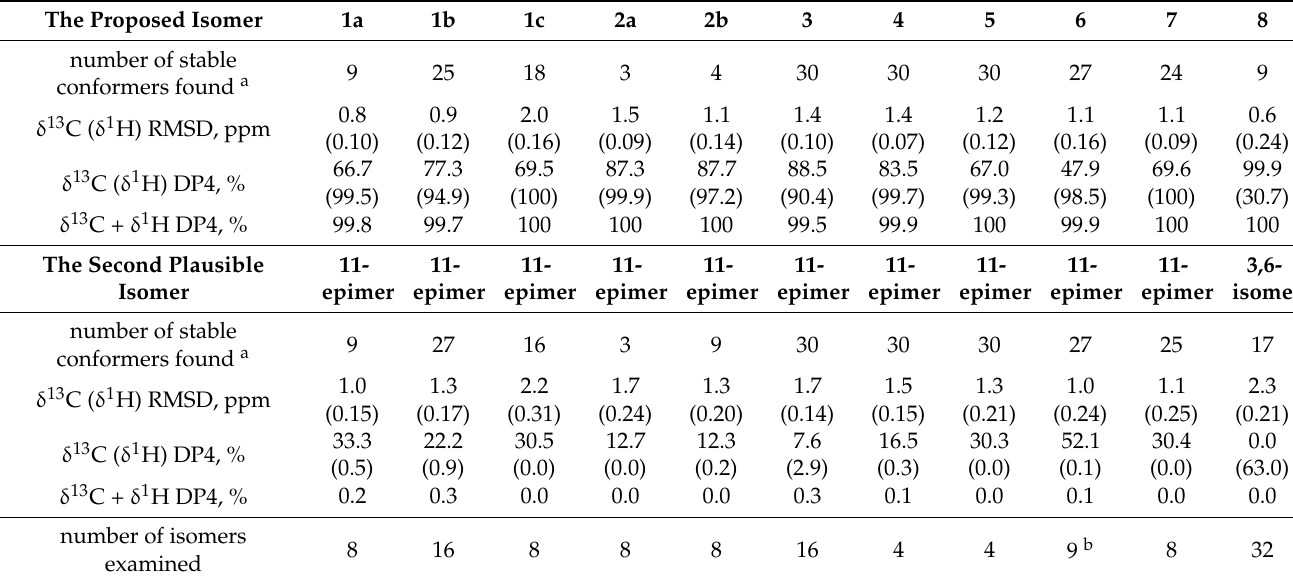
Table 2. DFT-based NMR chemical shift